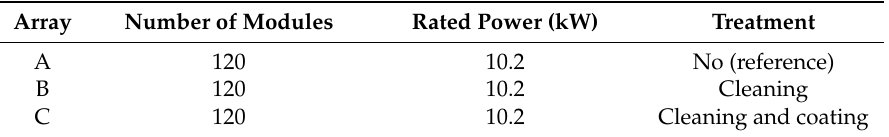
Table 1. Details of each CIGS